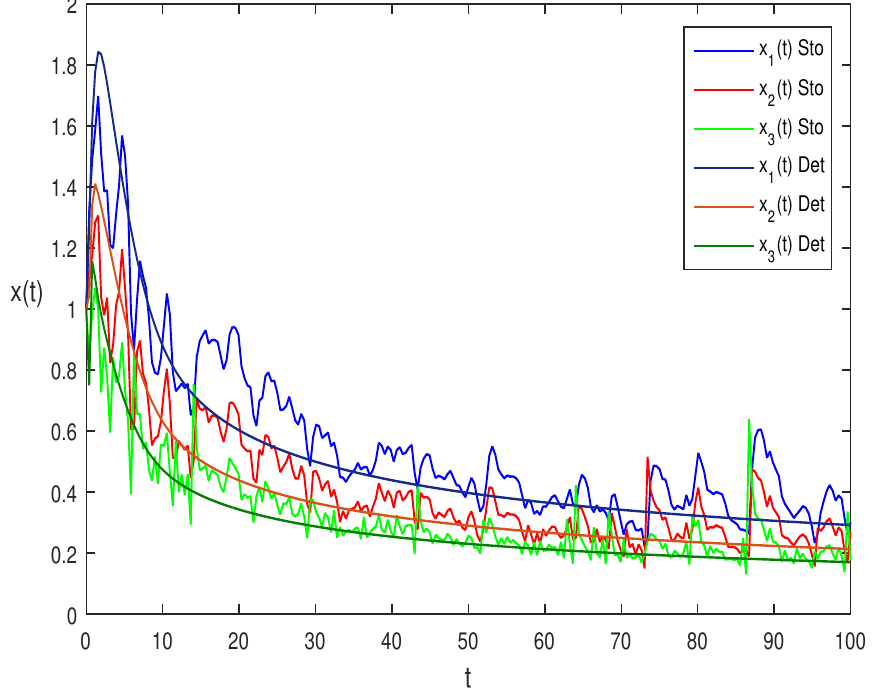
Figure 2. Comparisons of the solutions for each class of stochastic delay NGM systems from Equation (1) with the deterministic model ( σ i = 0 ) , i =